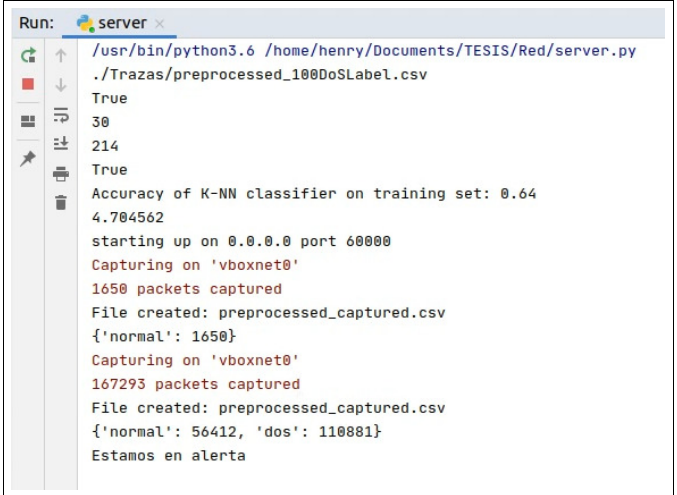
Figure 8. Machine Learning DoS attack